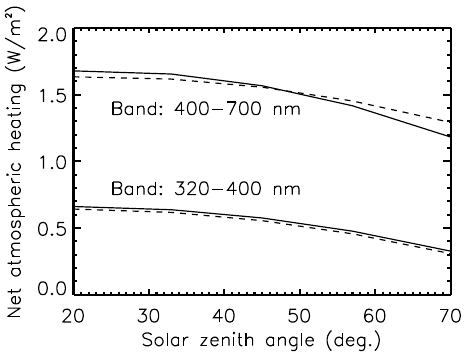
Fig. 3. NO 2 net atmospheric heating dependence on surface Fig.3. NO 2 netatmospheric heating dependence on surfacealbedo.